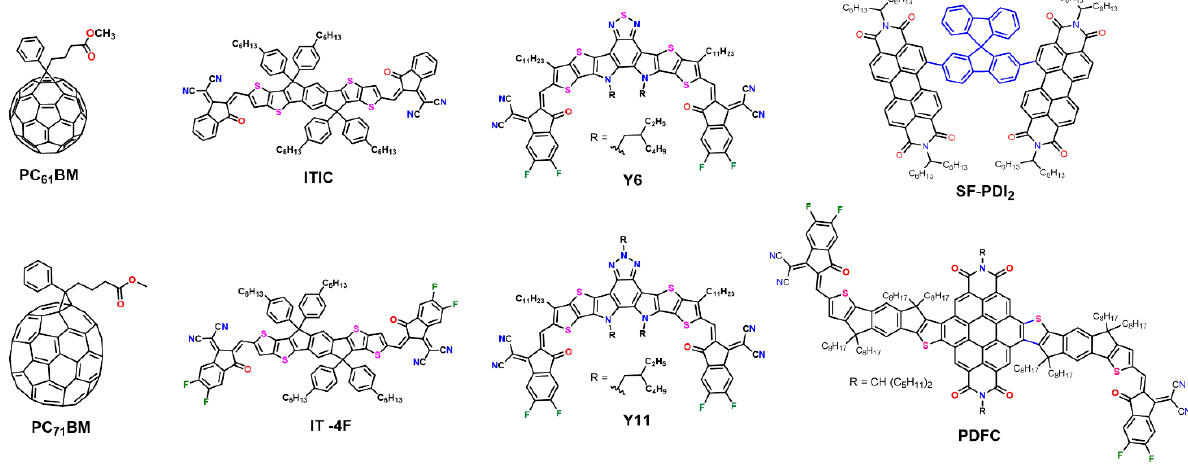
Figure 2. Chemical structures of PC 61 BM [25], PC 71 BM [26], ITIC [56], IT-4F [57], Y6 [59], Y11 [60], SF-PDI 2 [61] , and PDFC [62] as representative acceptors for high-performance OPV devices.